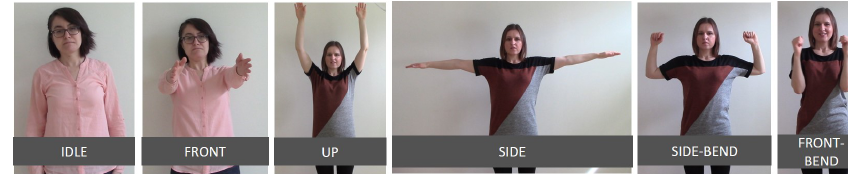
Figure 3. The arm motions and their labels (the participants provided their